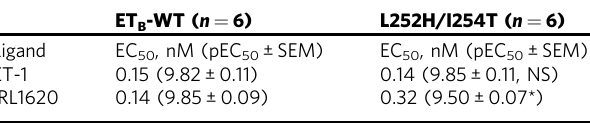
Table 4 Pharmacological parameters for the L252H